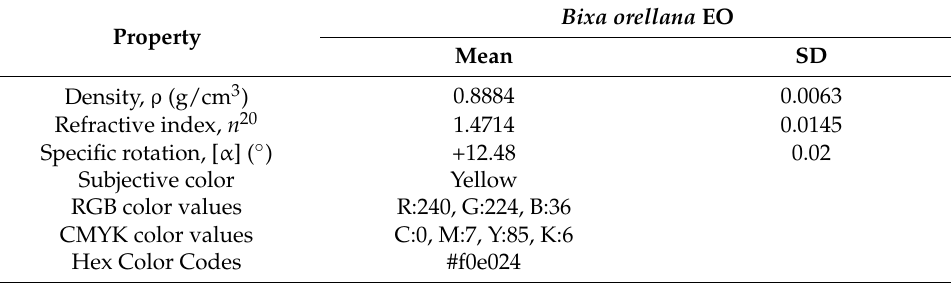
Table 1. Physical properties of the essential oil of Bixa orellana . Bixa orellana EO Property Mean SD Density, ρ (g/cm 3 ) 0.8884 Refractive index, n 20